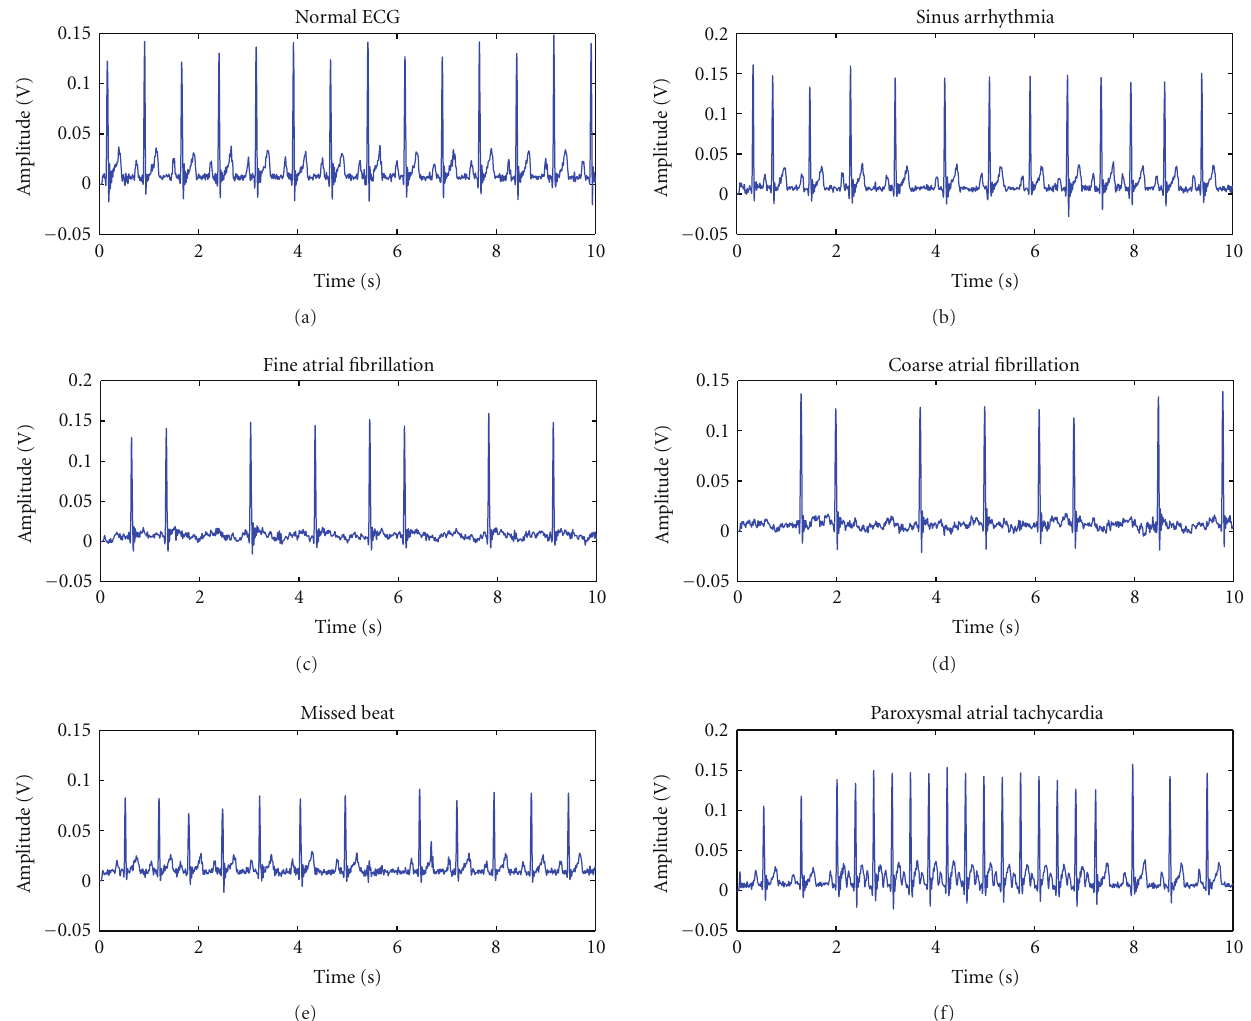
Figure 7: Signals of di ff erent cardiac arrhythmias produced by a MPS450 simulator, compared with a normal